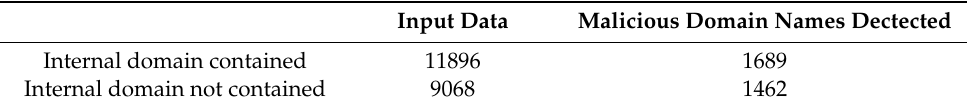
Table 8. Readd internal network data